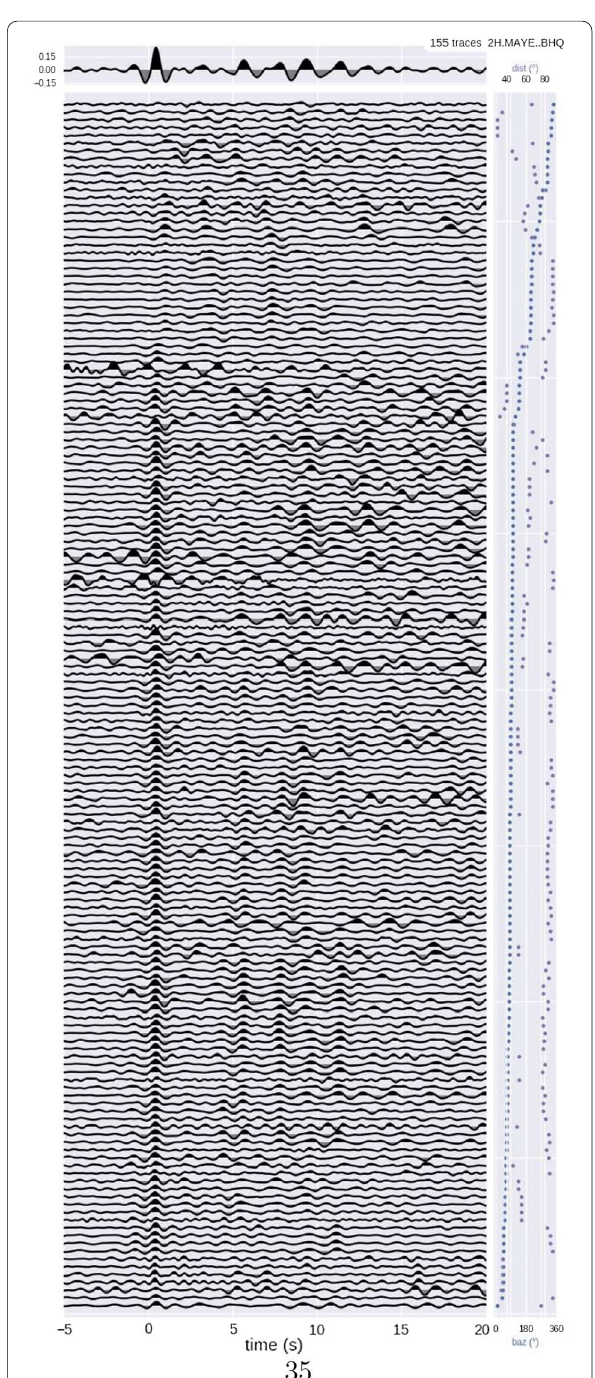
Fig. 4 (Left) Q component of the receiver function for the seismic station indicated in Fig. 3. (Right) All 155 receiver functions sorted by distance (purple dots) and back-azimuth (blue dots). (Top) Stacked receiver function